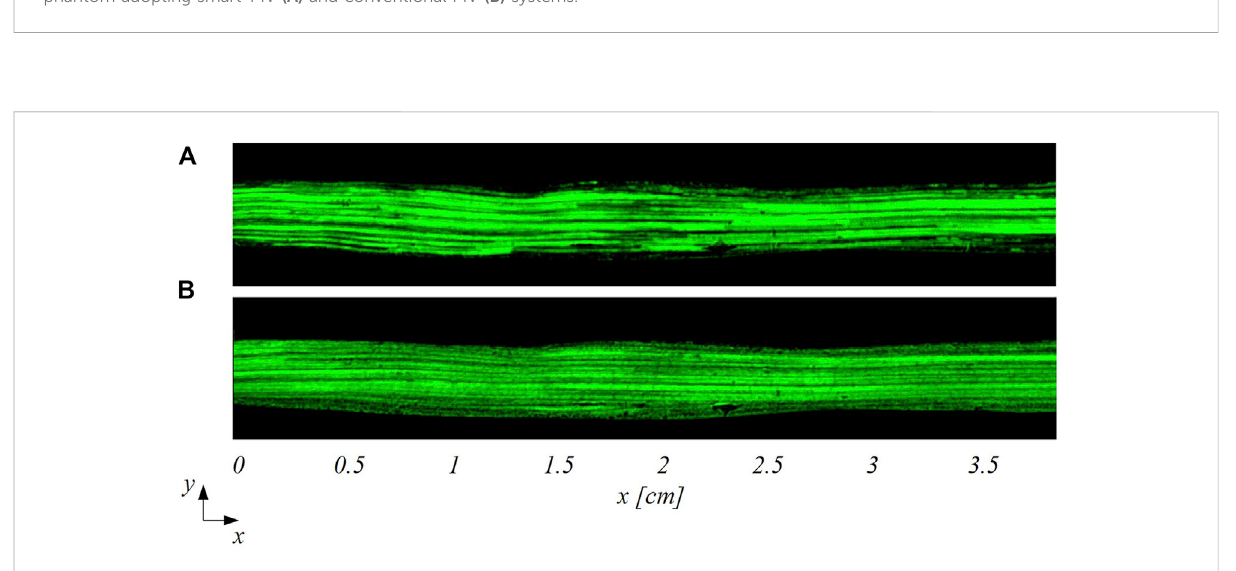
FIGURE 5 Particle trajectories-based visualization of the fl ow patterns in the healthy LAD at two different in fl ow Reynolds numbers: (A) Re inflow = 43; (B) Re inflow =